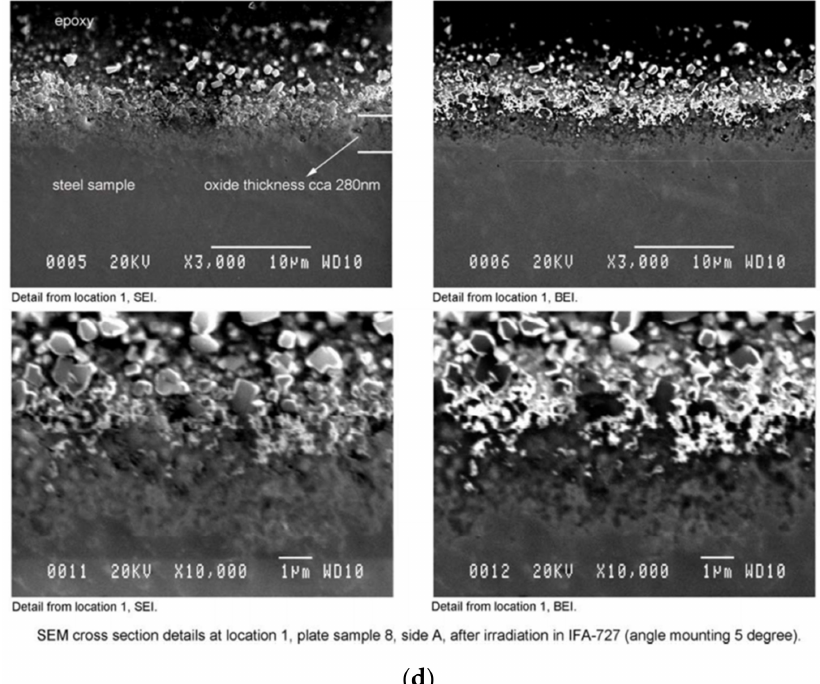
Figure 11. ( a ) Backscattered and secondary electron images from location 2 of 316LN SS plate specimen-4, side A with a 22-day exposure time. ( b ) Backscattered and secondary electron images from location 1 of 316LN SS plate specimen 2, side A with a 36-day exposure time. ( c ) Backscattered and secondary electron images from location 2 of 316LN SS plate specimen-4, side A with a 22-day exposure time. ( d ) Backscattered and secondary electron images from location 1 of 316LN SS plate specimen 8, side A with a 107-day exposure time.